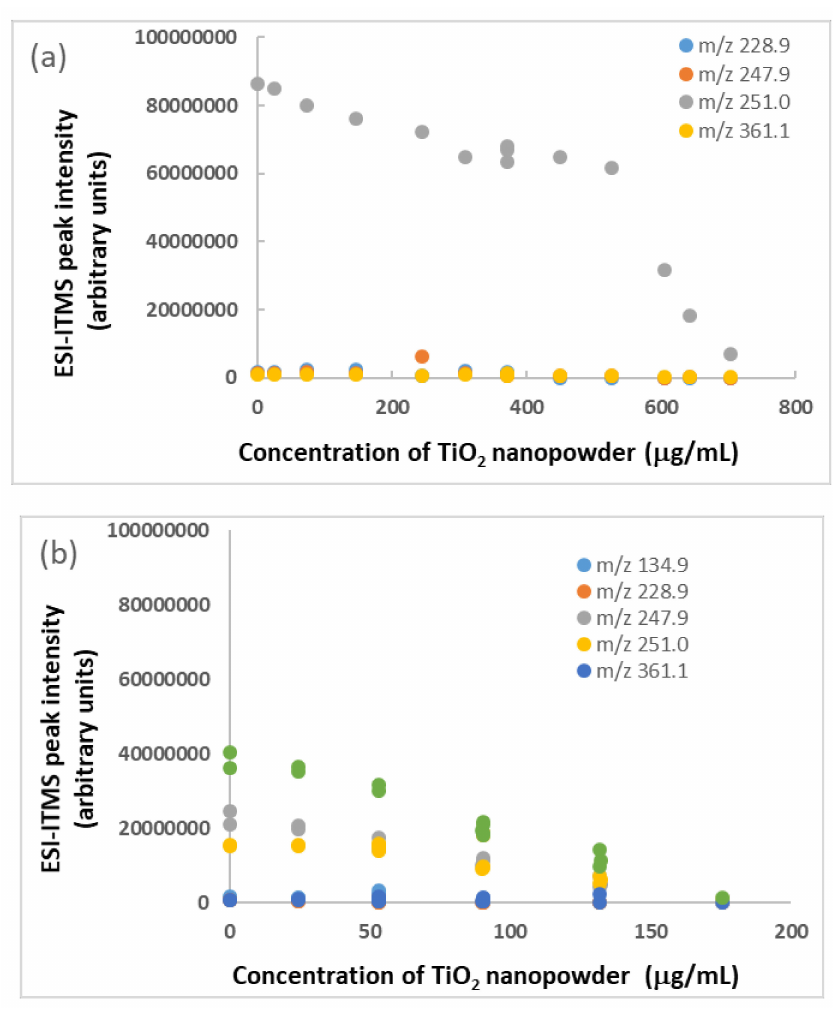
Figure 3. Binding of TiO 2 nanoparticles with BPA in standard solution (1.8 µ g / mL): ( a ) containing sodium formate (41 µ g / mL) and ( b ) in absence of sodium formate. Relative standard deviation of each data point =